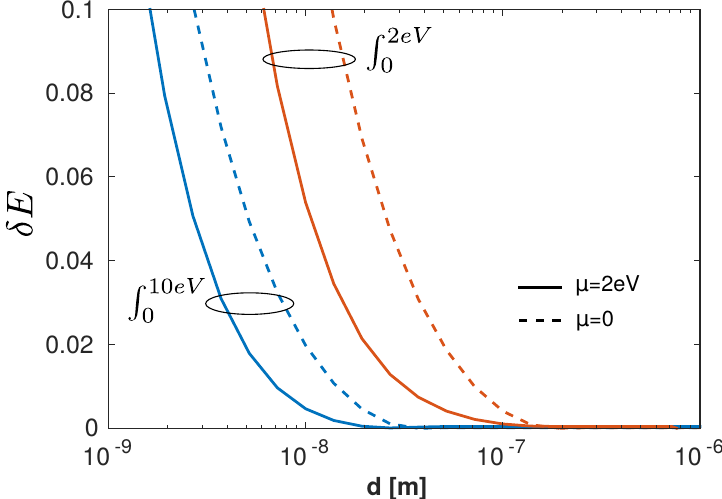
Figure 5. Relative deviation from the Casimir energy when truncating the integral Equation (7) at ¯ h ω max = 2eV (red) or 10 eV (blue) compared to infinity. Dashed lines are for intrinsic graphene sheets and full for µ =